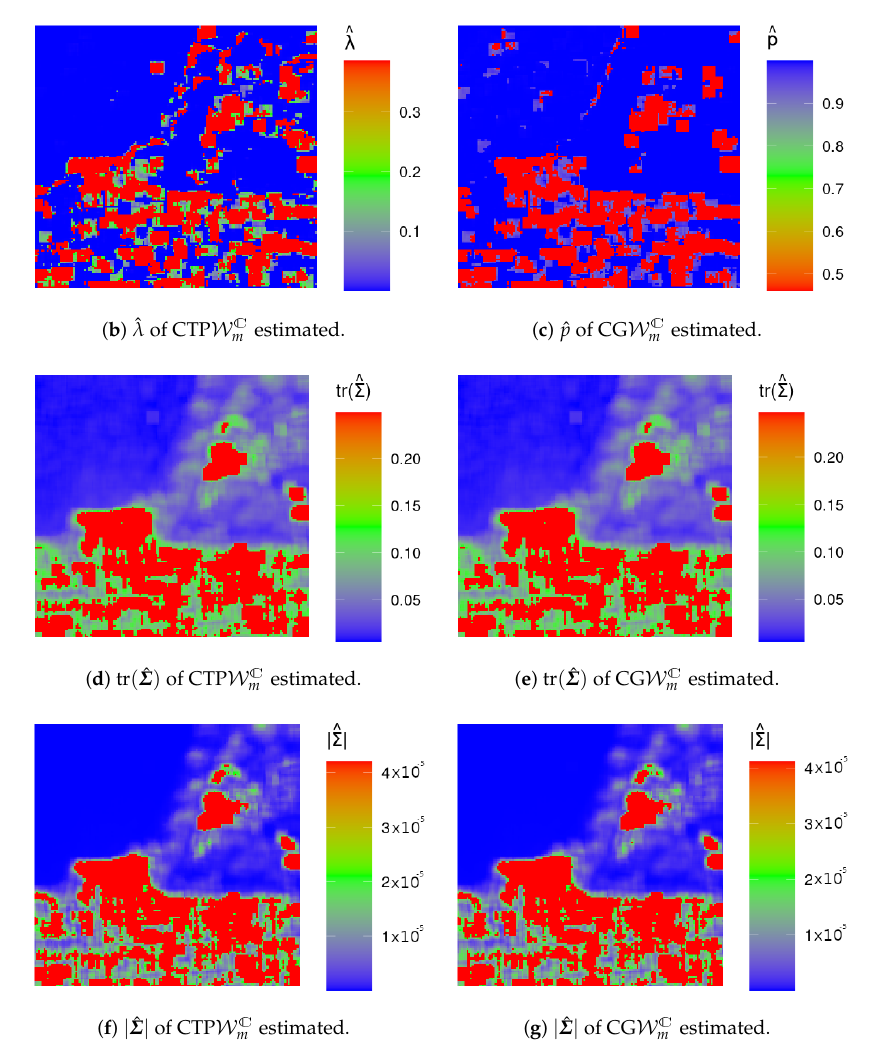
Figure 5. Maps of estimated parameters of San Francisco for CTP W C m ( left ) and CG W C m ( right ) distributions, respectively. MLE estimates for λ , tr ( Σ ) , and | Σ | under CTP W tively. Figure 5c,e,g display the maps of MLEs of p , tr ( Σ ) , and | Σ | , respectively, under the C CG W m